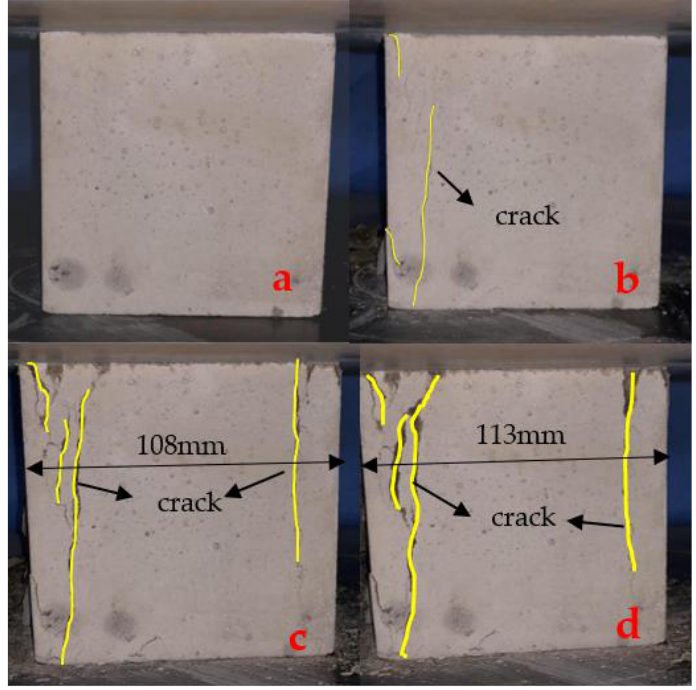
Figure 4. Compression failure process of 3D-TRSSC. ( a ) Pre-cracking; ( b ) initial cracking; ( c ) development of cracking; ( d ) limit of cracking.